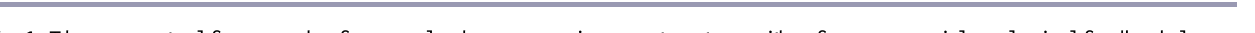
Fig. 1 . The conceptual framework of a complex human-environment system with a focus on social-ecological feedback loops and adaptation in response to policy processes and instruments, as well as climate and market changes. Note: Rectangular boxes are the subsystems whose dynamics are endogenously represented by the study. Text with no outline are ecological or social processes that genuinely form the feedback loops. Circular boxes are factors considered external in this